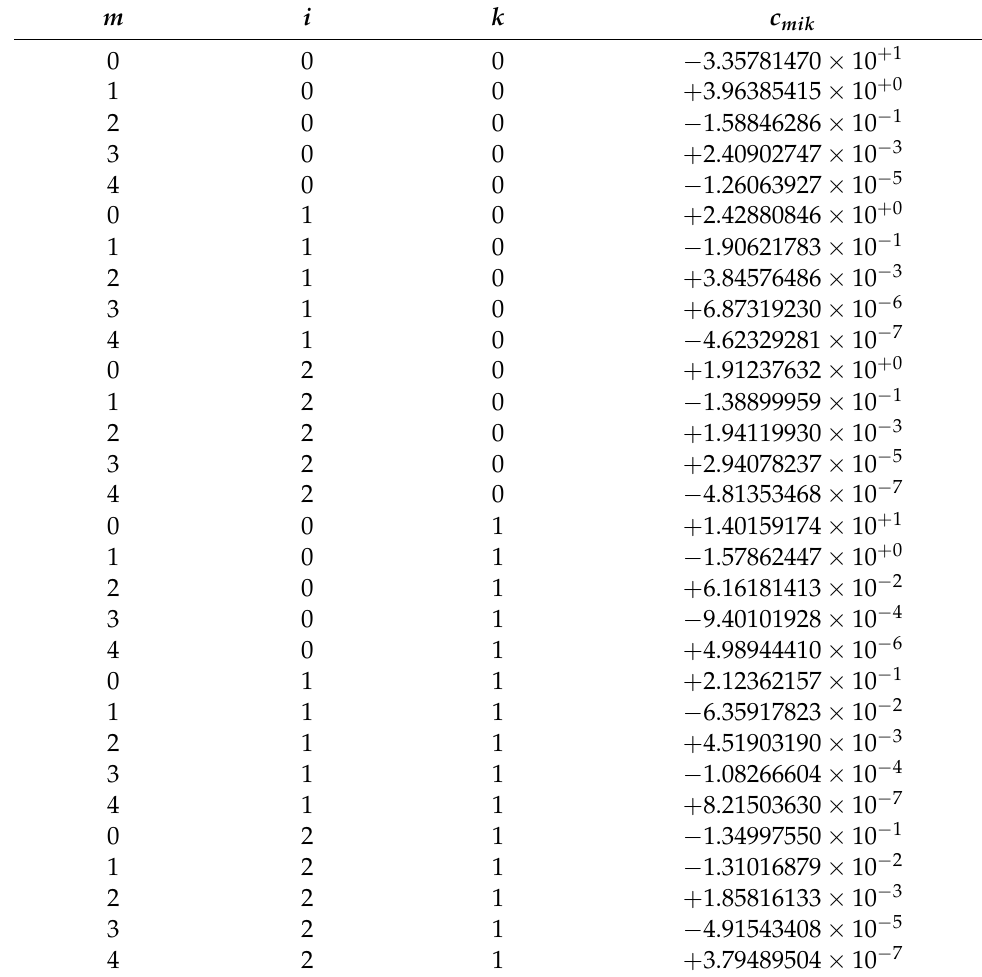
Table A1. List of the ASIT GMF coefficients c mik